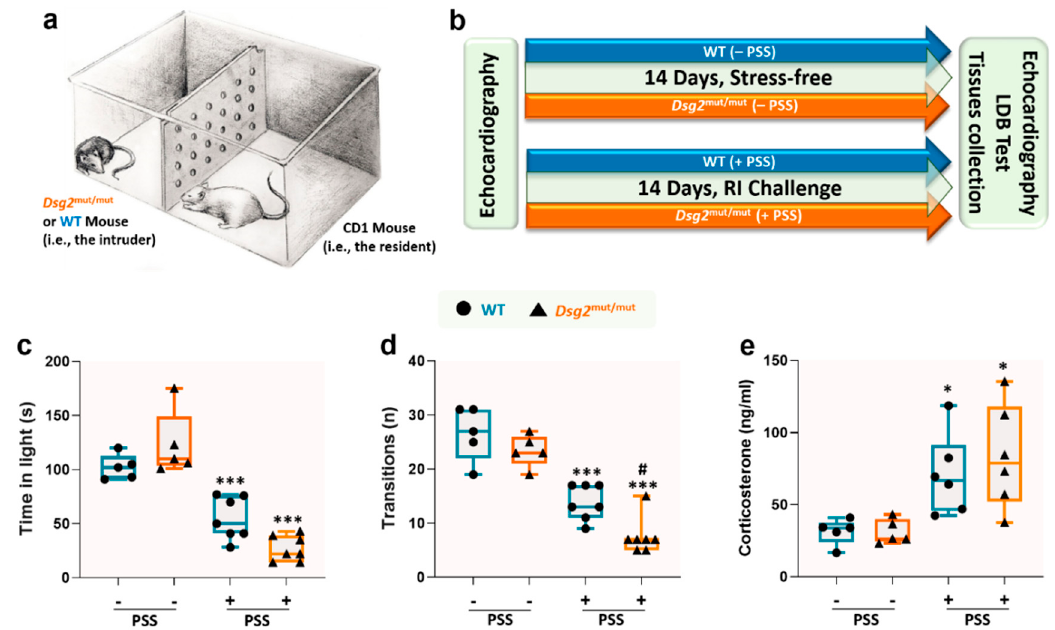
Figure 3. The resident-intruder paradigm induces anxiety behavior and a surge in corticosterone levels. Behavioral parameters assessed via the light-dark box (LDB) test and corticosterone levels from WT and Dsg2 mut / mut mice in presence or absence of resident-intruder (RI) paradigm. ( a ) Illustrative schematic depicting the RI paradigm test. ( b ) Graphical timeline for the experimental protocol. ( c ) Time spent in the light chamber during the LDB test. ( d ) Number of transitions between the two chambers during the LDB test. ( e ) Circulating corticosterone levels. Data presented as box-whisker plots, n = 5–7 mice / parameter / cohort. PSS, psychosocial stress. * p < 0.05, *** p < 0.001 WT ( + PSS) vs. WT (–PSS) or Dsg2 mut / mut ( + PSS) vs. Dsg2 mut / mut (–PSS); # p < 0.05 Dsg2 mut / mut ( + PSS) vs. WT ( + PSS) using One-Way ANOVA with Tukey’s post-hoc analysis.